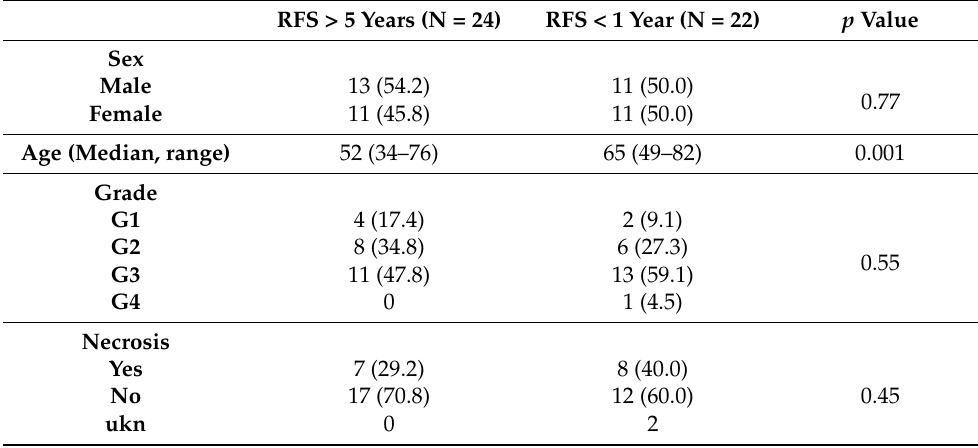
Table 1. Patients’ characteristics (valid cases and